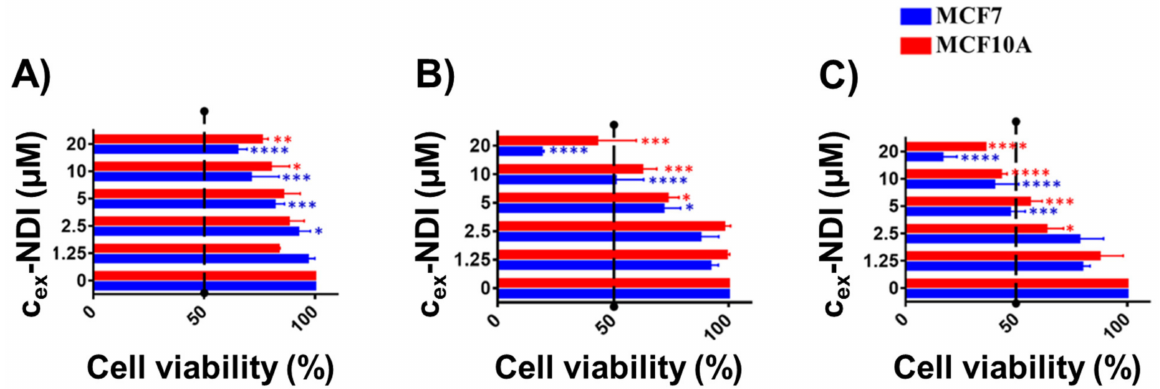
Figure 9. Effects of increasing concentrations of c ex -NDI (1.25–20 µ M) on human breast MCF7 cells and non-tumorigenic human breast MCF10A cells upon ( A ) 24, ( B ) 48 and ( C ) 72 h incubation. Cell viability values are expressed as the percentage of cell viability obtained for treated vs. control cells grown in the absence of the molecule. Three independent experiments were performed, and, for all the experimental points, * p < 0.05, ** p < 0.01, *** p < 0.001 or **** p < 0.0001 were obtained for treated vs. control